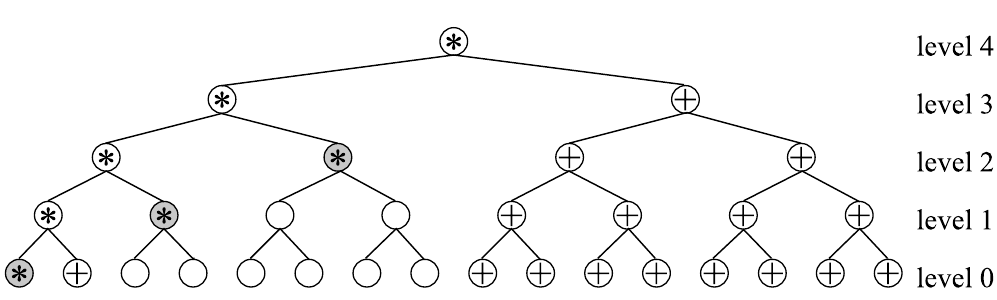
Figure 2. A compact